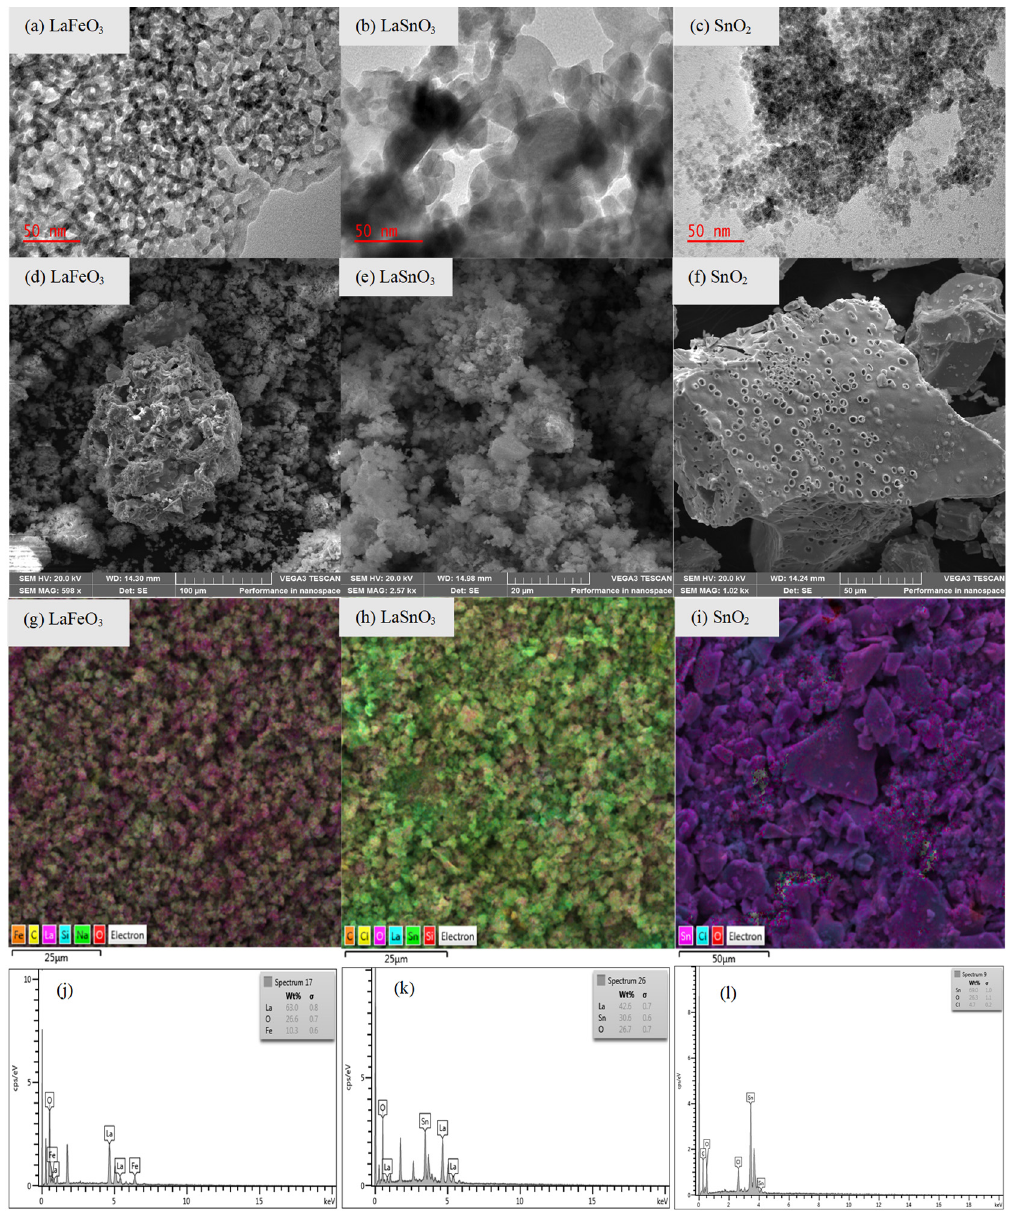
Figure 3. TEM images of the synthesized perovskites ( a – c ); their corresponding SEM images ( d – f ); elemental mapping images ( g – i ); and the EDS spectra ( j – l ).